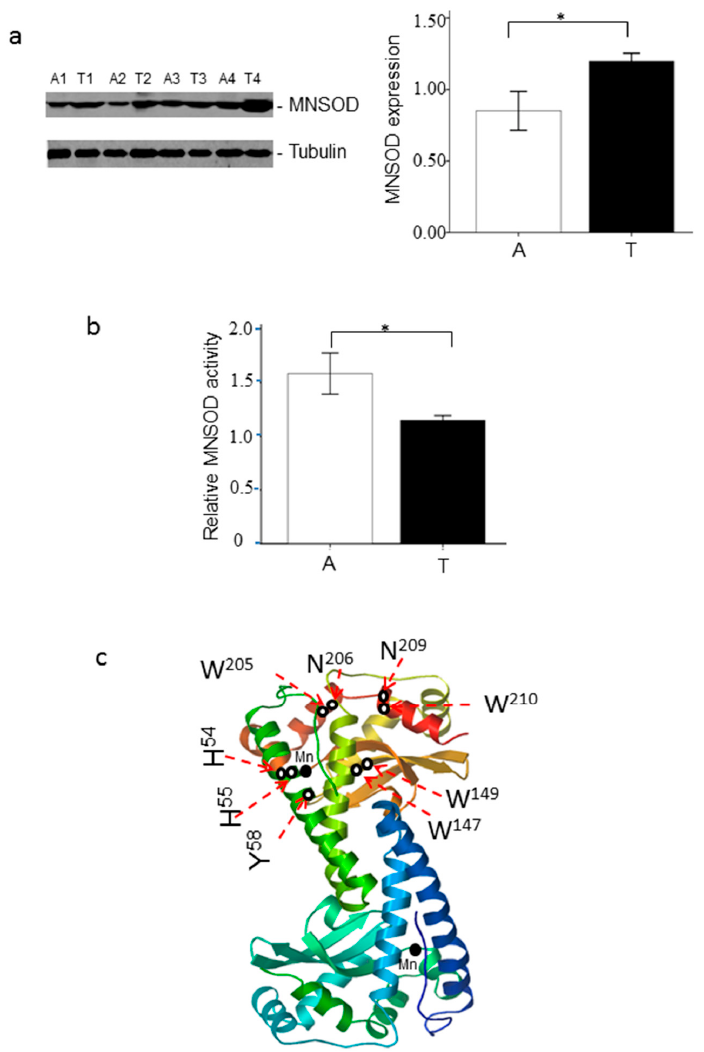
Figure 4. MNSOD expression, enzymatic activity and the potential oxidation hotspots of MNSOD. ( a ) The expression of MNSOD in adjacent (A) and ccRCC (T) tissues. Four individual ccRCC and adjacent tissue lysates were separated by SDS-PAGE and the expression of MNSOD was detected by Western blotting. Tubulin served as the loading control (* p < 0.05, n = 4); ( b ) MNSOD enzymatic activity in adjacent (A) and ccRCC (T) tissues. Superoxide dismutase (SOD) activity kit was used to measure MNSOD enzymatic activity. The relative MNSOD enzymatic activity was normalized by MNSOD expression (* p < 0.05, n = 4); ( c ) the potential oxidation hotspots in three dimensional structure of MNSOD. The ribbon structure of MNSOD subunit (1LUV.pdb) is depicted with the two separate polypeptide chains. The active sites (manganese ions, Mn) are depicted as solid spheres and the oxidative modification sites (H 54 , H 55 , Y 58 , W 147 , W 149 , W 205 , N 206 , N 209 , W 210 ) are indicated as red dashed arrows. The 3D structure shows the three oxidation hotspots (hotspot 1 (H 54 , H 55 , Y 58 ), hotspot 2 (W 147 , W 149 ) and hotspot 3 (W 205 , N 206 , N 209 , W 210 )) are distributed in the surface of homotetrameric MNSOD and point to protein internal, which composite a hydrophobic side chain and affect the molecular structure of MNSOD. The colors in the ribbon structure of MNSOD subunit are the automatically displayed colors according to 1LUV.pdb.